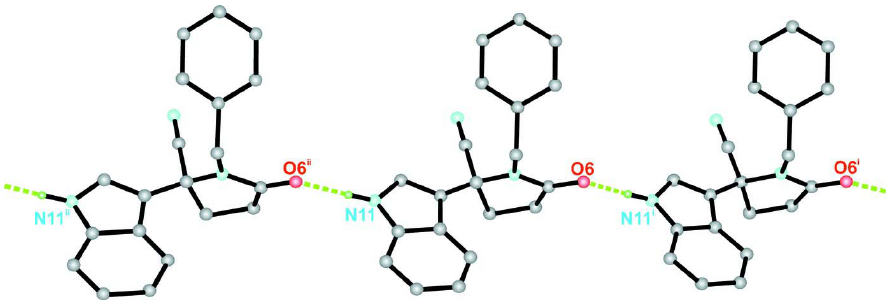
A view of molecular structure of the title compound, showing the atomic numbering scheme and displacement ellipsoids drawn at the 50% probability level. H atoms are omitted for clarity.